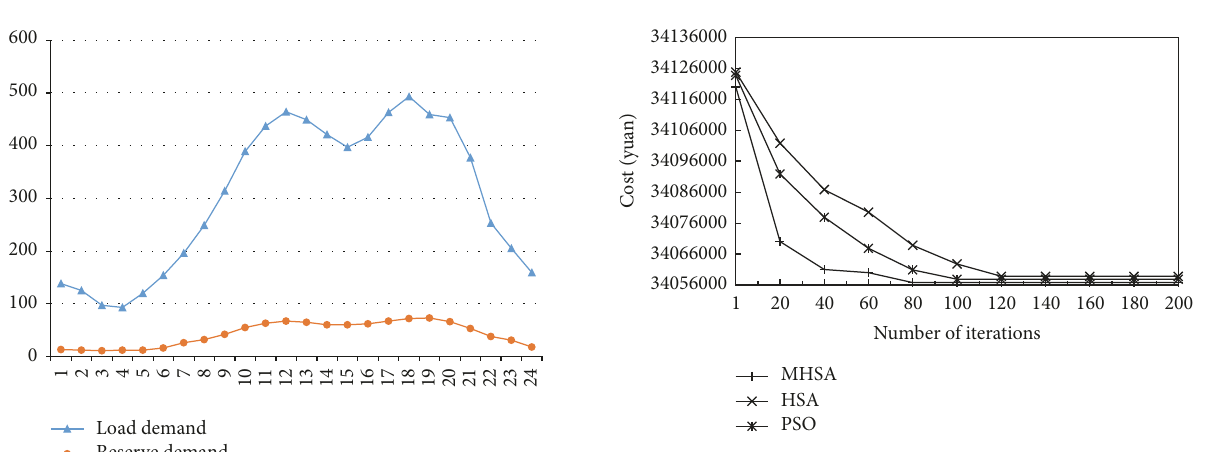
Figure 3: Comparison of the convergence condition of MHSA, HSA, and PSO for Case 1.